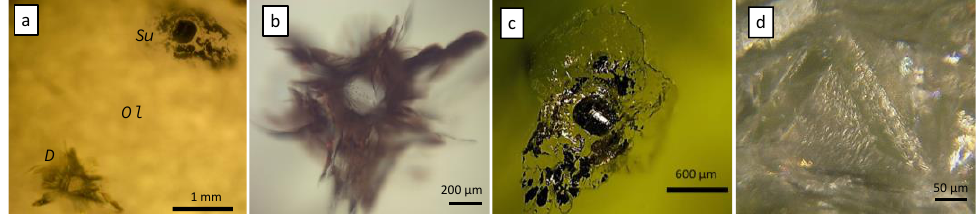
Figure 3. Diamond and sulfide inclusions in olivine from the Udachnaya kimberlite (Yakutia): ( a ) both inclusions; ( b ) well-defined octahedral morphology of the diamond crystal; ( c ) sulfide inclusion with a cracking halo; ( d ) resorbed facet of diamond.